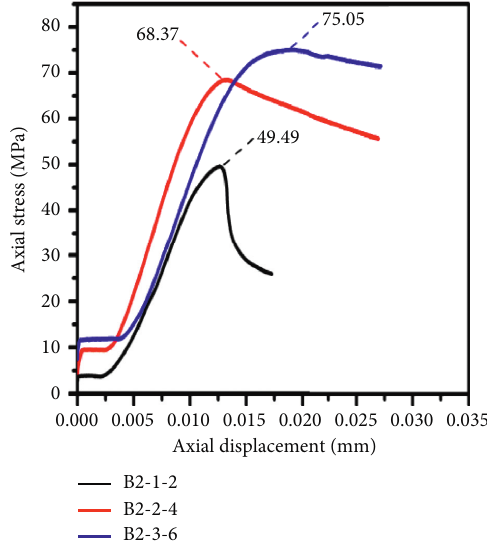
Figure 14: Axial displacement-axial stress curve of group B2.